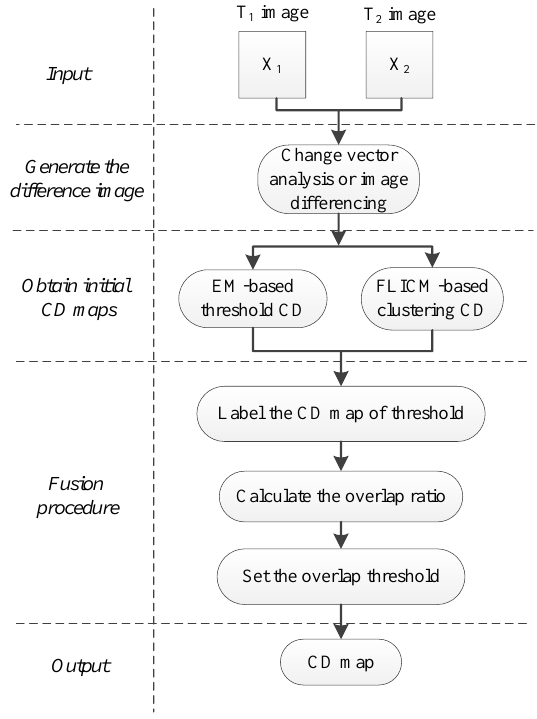
Figure 1. Flowchart of the designed